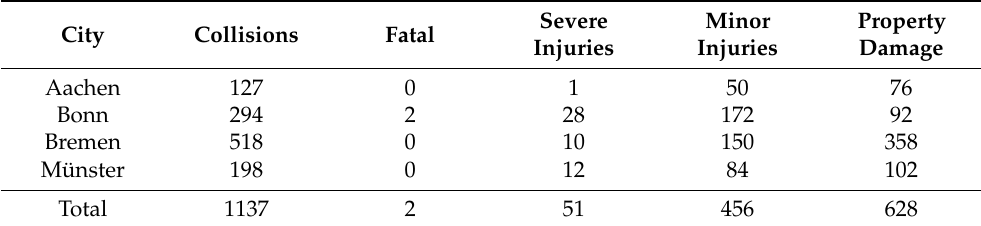
Table 6. Number of collisions and their classification per